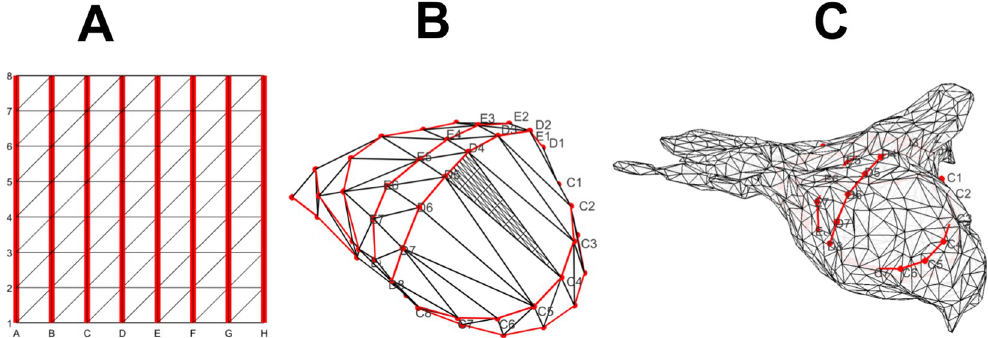
Fig 1. Overview of 2D and 3D geometries of AF maps. (A) Triangularized 2D grid with electrode splines highlighted in red. (B) Corresponding 3D triangularized mesh of the electrode basket, with electrode splines again highlighted in red. The triangle C4-D4-D5 shows the interpolated mesh after three subdivisions; this was omitted on other faces for clarity. (C) Corresponding atrial mesh determined from NavX or Carto, also with basket splines in red.